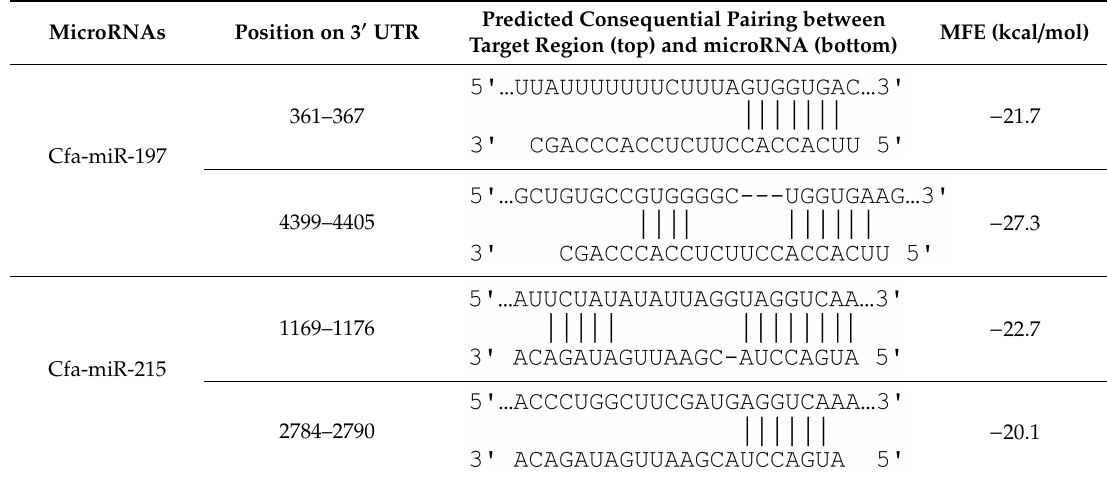
Table 4. Target site prediction and hybridization pattern of Karyopherin Alpha 6 (KPNA6)-microRNAs. Predicted Consequential Pairing between MicroRNAs Position on 3 (cid:48) UTR Target Region (top) and microRNA